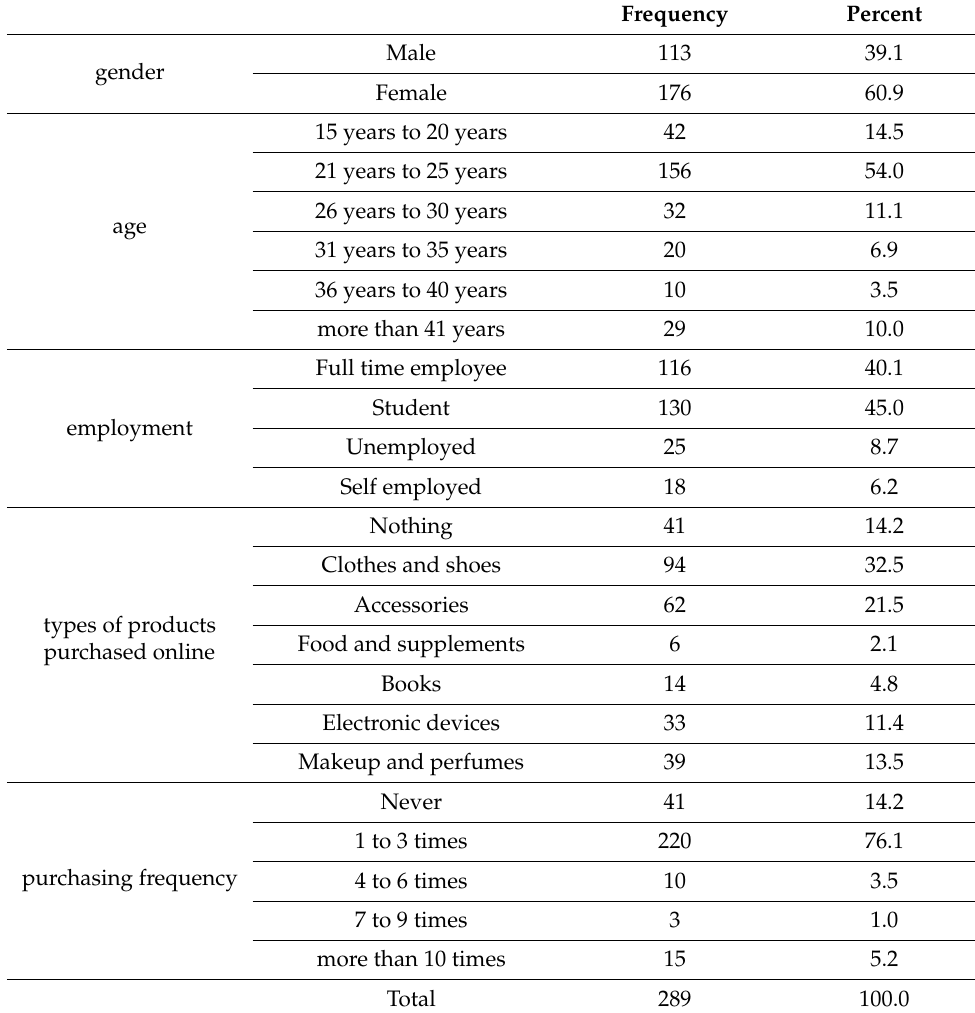
Table 1. Sociodemographic